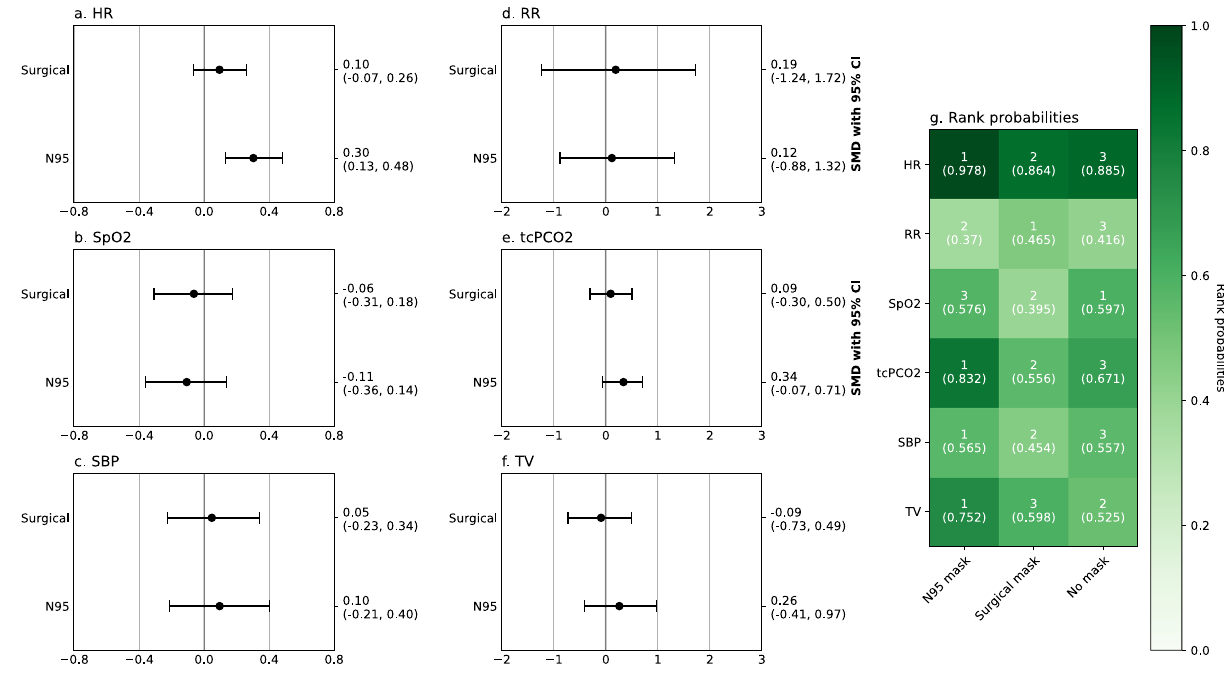
Figure 4. Network meta-analysis of N95 filtering facepiece respirators and surgical masks’ effect on physiological outcomes during low-intensity activities. Numbers in rank probabilities heatmap represent rank with the highest probability and corresponding probability for given measure and condition; HR heart rate,